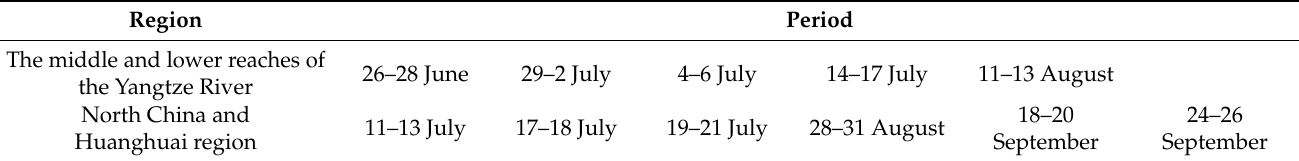
Table 1. The eleven heavy rainfall events from June to September of 2021. Region Period The middle and lower reaches